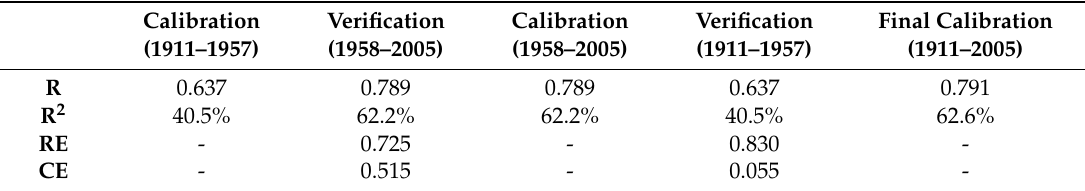
Figure 8. Comparison of the projected (dashed line) and actual (solid line) tree ‐ ring chronology for the common period 1911–2005. Grey area indicates the uncertainty (±1 root mean squared error) in the projected climate ‐ induced tree growth. Table 3. Statistic of split sample calibration ‐ verification test. R: correlation coefficient; R 2 : the proportion of variance explained by the regression model; RE: reduction of error; CE: coefficient of efficiency.